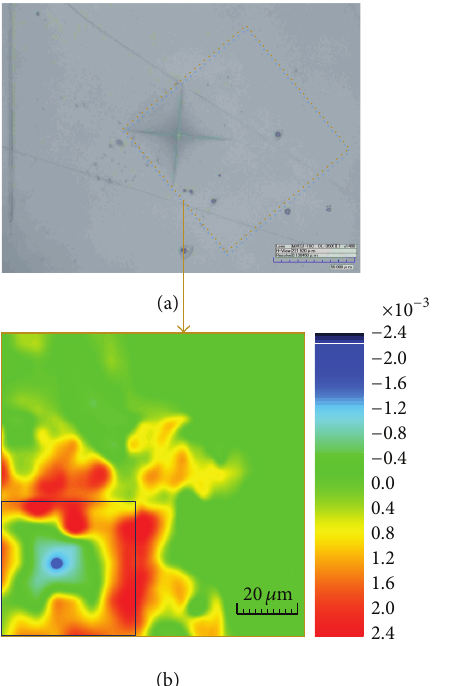
Figure 9: The experiment on the Vickers microindentation. (a) The imageofthesampleandRamanmappingregion,(b)thedistribution of residual in-plane principal strain ( 𝜀